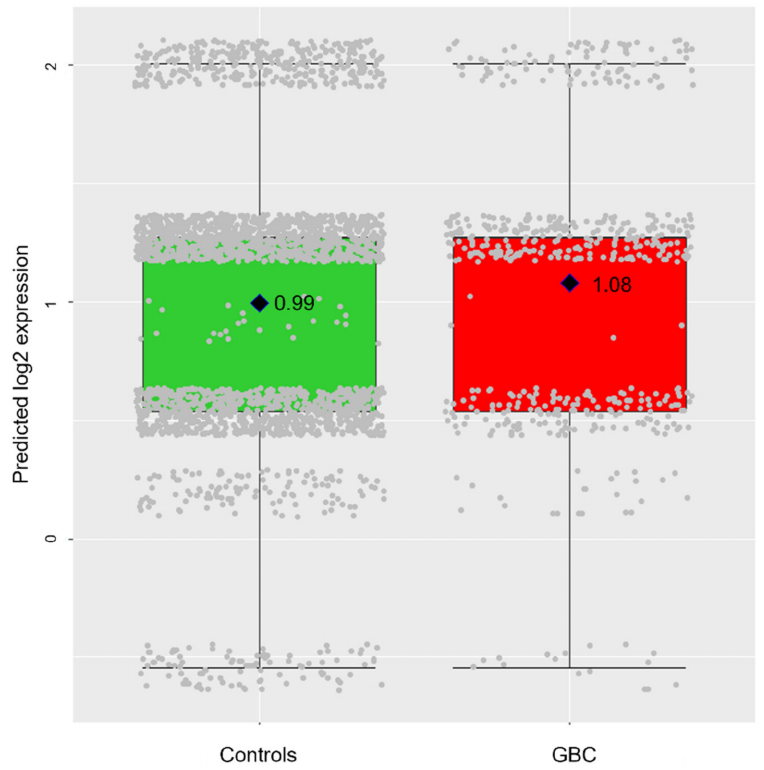
Figure 4. Predicted genotype-based log2 LINC00662 expression in the lncRNA- GBC association dataset. Rhombuses represent the average genotype-based log2 expression in population-based controls and GBC